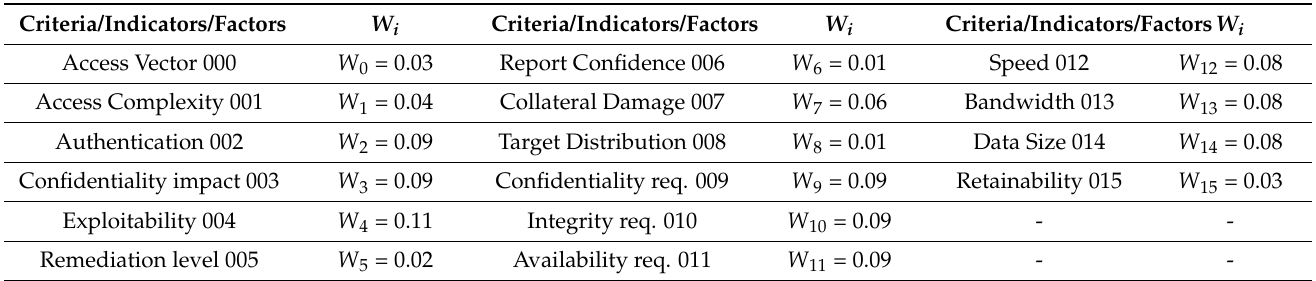
Table 5. The combinatorial weights of the CVSS and dynamic 5G network